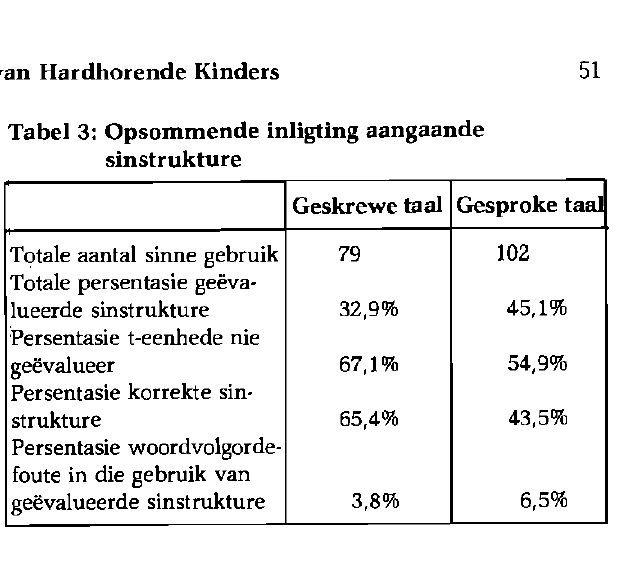
Tabel 4: Voorkoms van persentasie foutiewe sinsvorme tydens gesproke en geskrewe taal % voorkoms Foutiewe sinsvorme